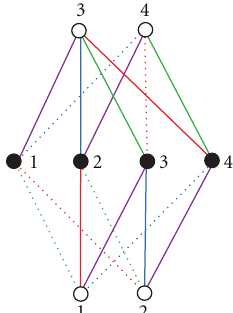
Table 4: The boson up linkage matrices for the chiral multiplet shadow. The fermion time-like down matrices are determined from these via